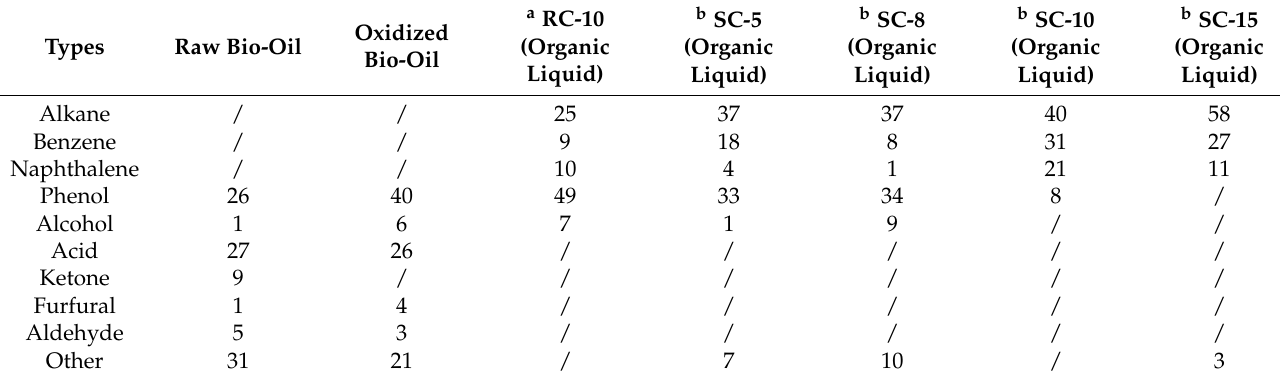
Table 2. GC/MS analysis of raw bio-oil, oxidized bio-oil, and organic liquids (%).